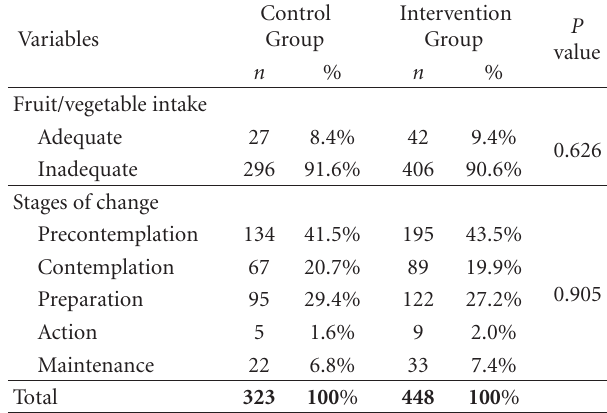
Table 2: Comparability between the intervention and control groups regarding fruit and vegetable intake and stages of change after the proposed intervention (analysis of the repeated measure- ments model using weighted minimum squares).